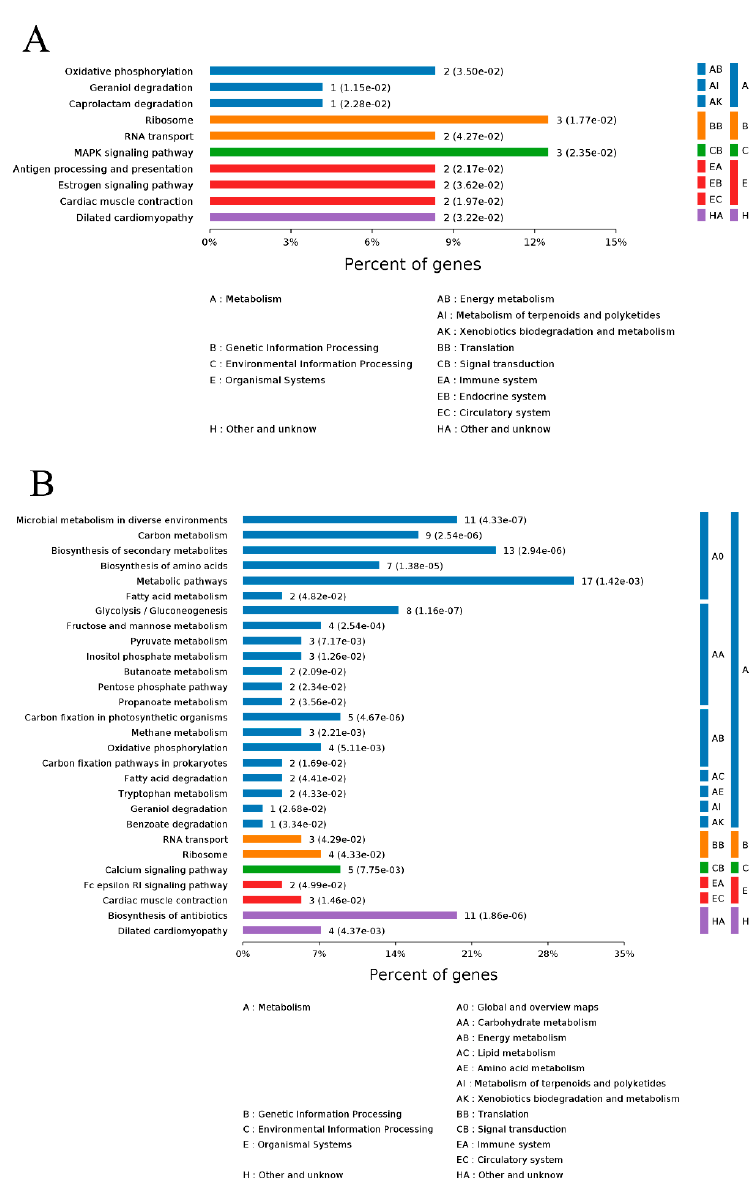
Figure 6. KEGG pathway analyses of differentially significant expressed proteins (DSEPs): ( A ) Day 0 vs. Day 6; and ( B ) Day 0 vs. Day 12.